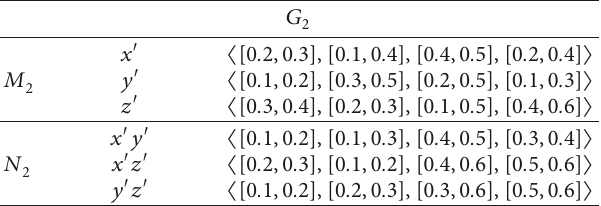
Table 2: The degree of MV and N-MV of the nodes and edges in G